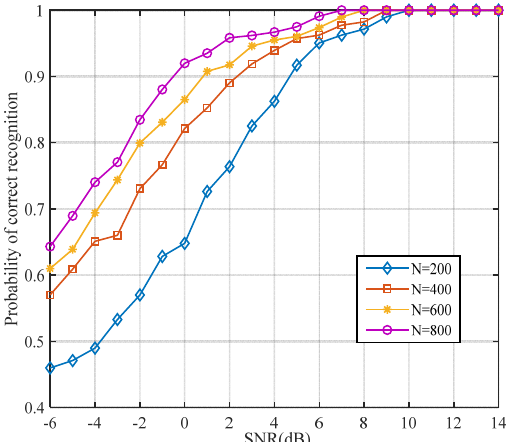
Figure 16. Influence of number of samples on the recognition rate under the Condition of Gaussian White Noise.